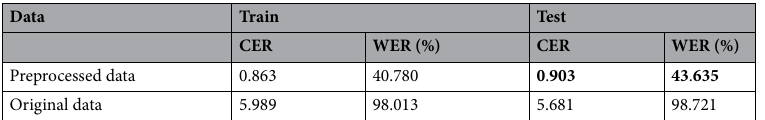
Table 2. Original and preprocessed data experiment result. Significant values are in [bold].